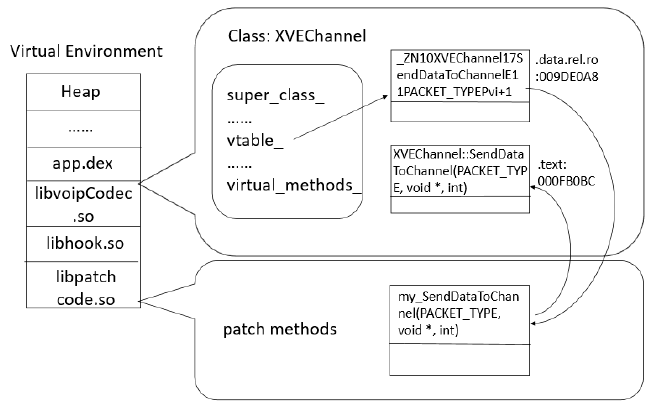
Figure 3. The application’s memory layout with hooking a method.